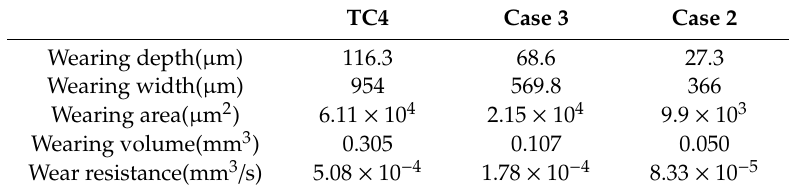
Table 5. The size of the wear region of the cladding layer and substrate under di ff erent specific